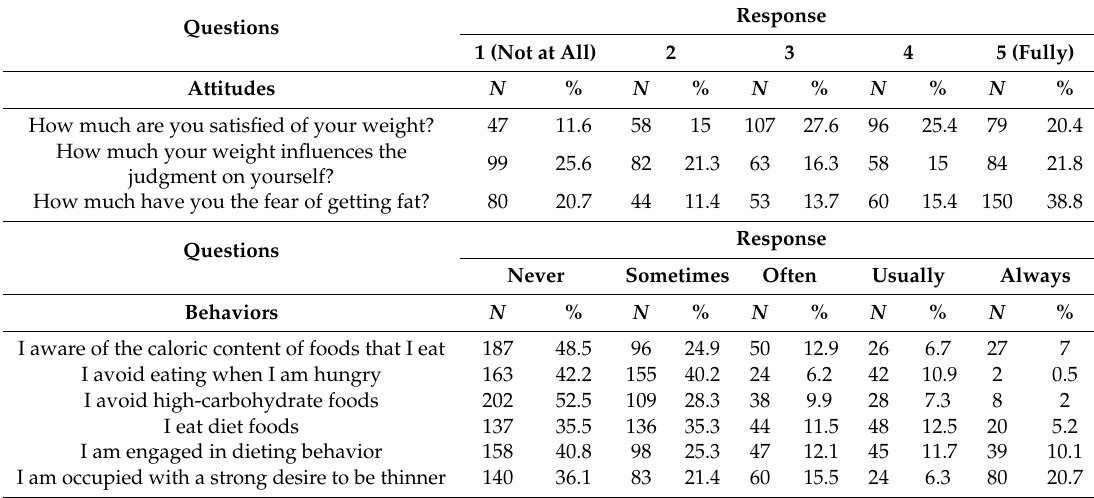
Table 4. Responses of the participants regarding eating attitudes and